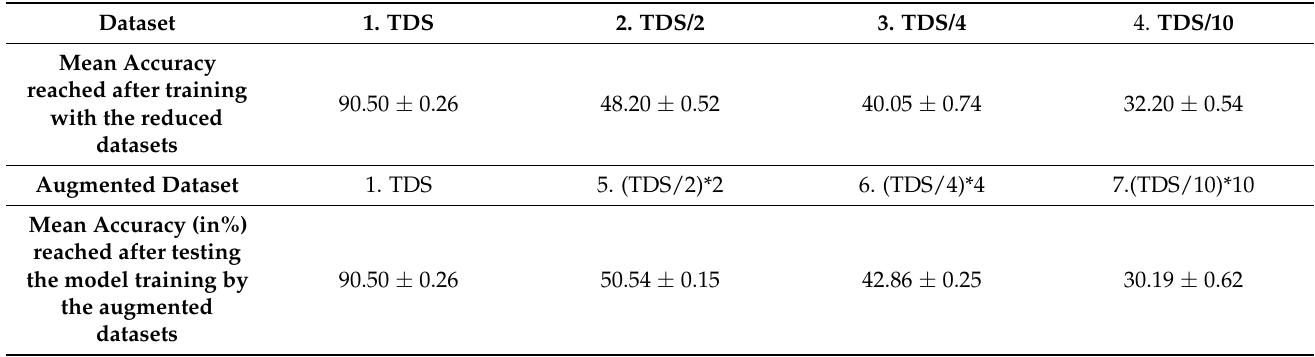
Table 6. Experiment-1: Performance comparison; TDS is the original dataset where 100 graphs are for training and 50 graphs for testing. The Numerical Augmentation ratio is Dataset ×